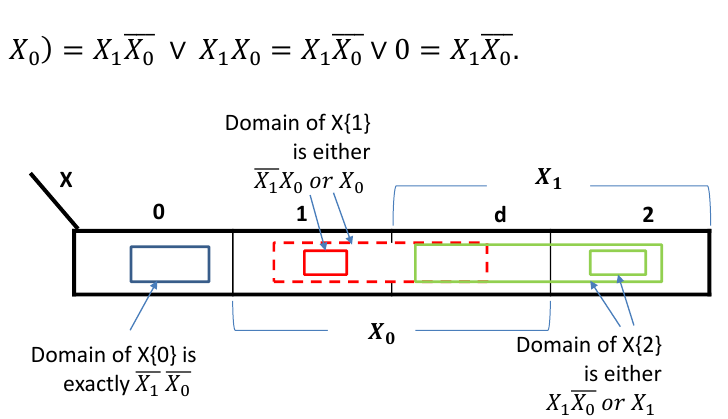
Fig. 1. Double labeling for the ternary variable 𝑋, by either specifying the four values of {0, 1, 𝑑, 2} or identifying the domains of 𝑋